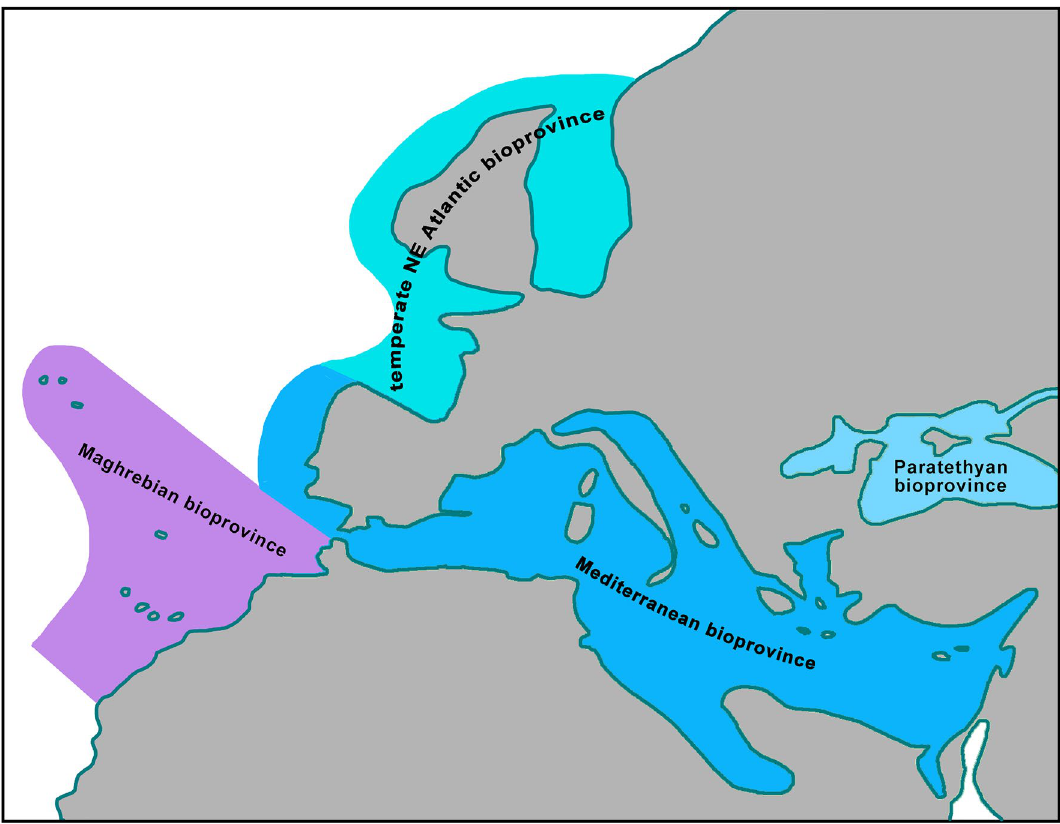
Fig. 32 Conceptual map of marine fish bioprovinces during the Early Pliocene. From west to east: transitional tropical Maghrebian bioprovince; subtropical Mediterranean bioprovince; temperate northeastern Atlantic bioprovince; Paratethyan bioprovince. Paleogeographic configuration based on Popov et al. (2004); delimitation of bioprovinces altered from Avila et al.